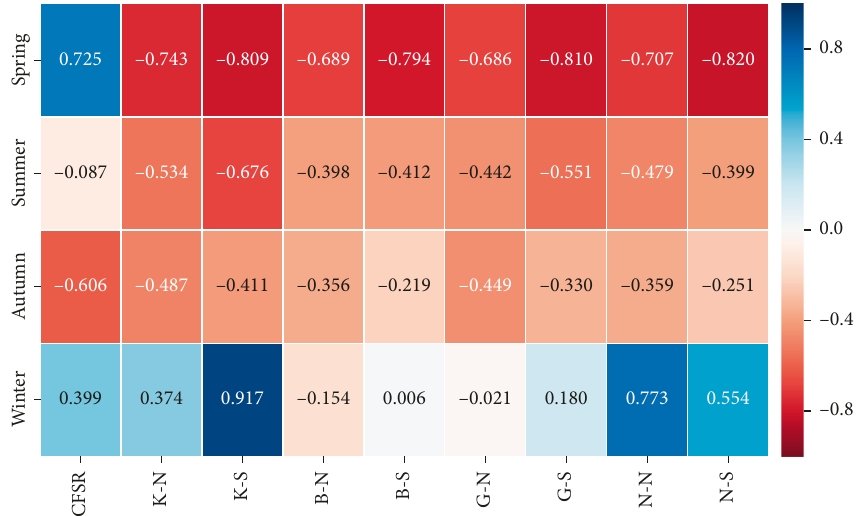
Figure 9: The same as Figure 8, but for convective inhibition